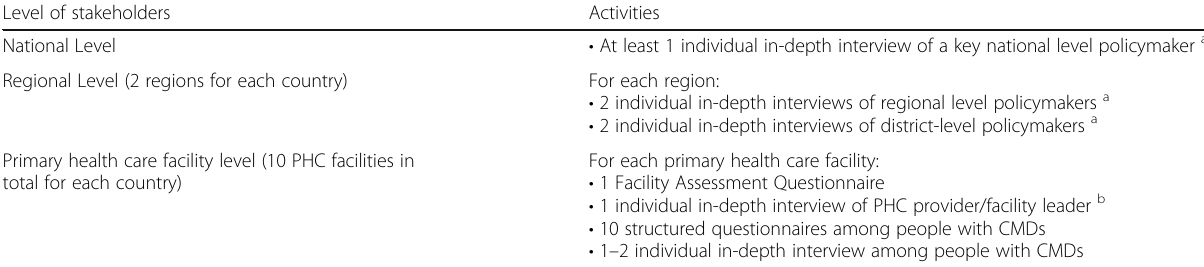
Table 1 Overview of the scope of fieldwork research activities Level of stakeholders Activities National Level